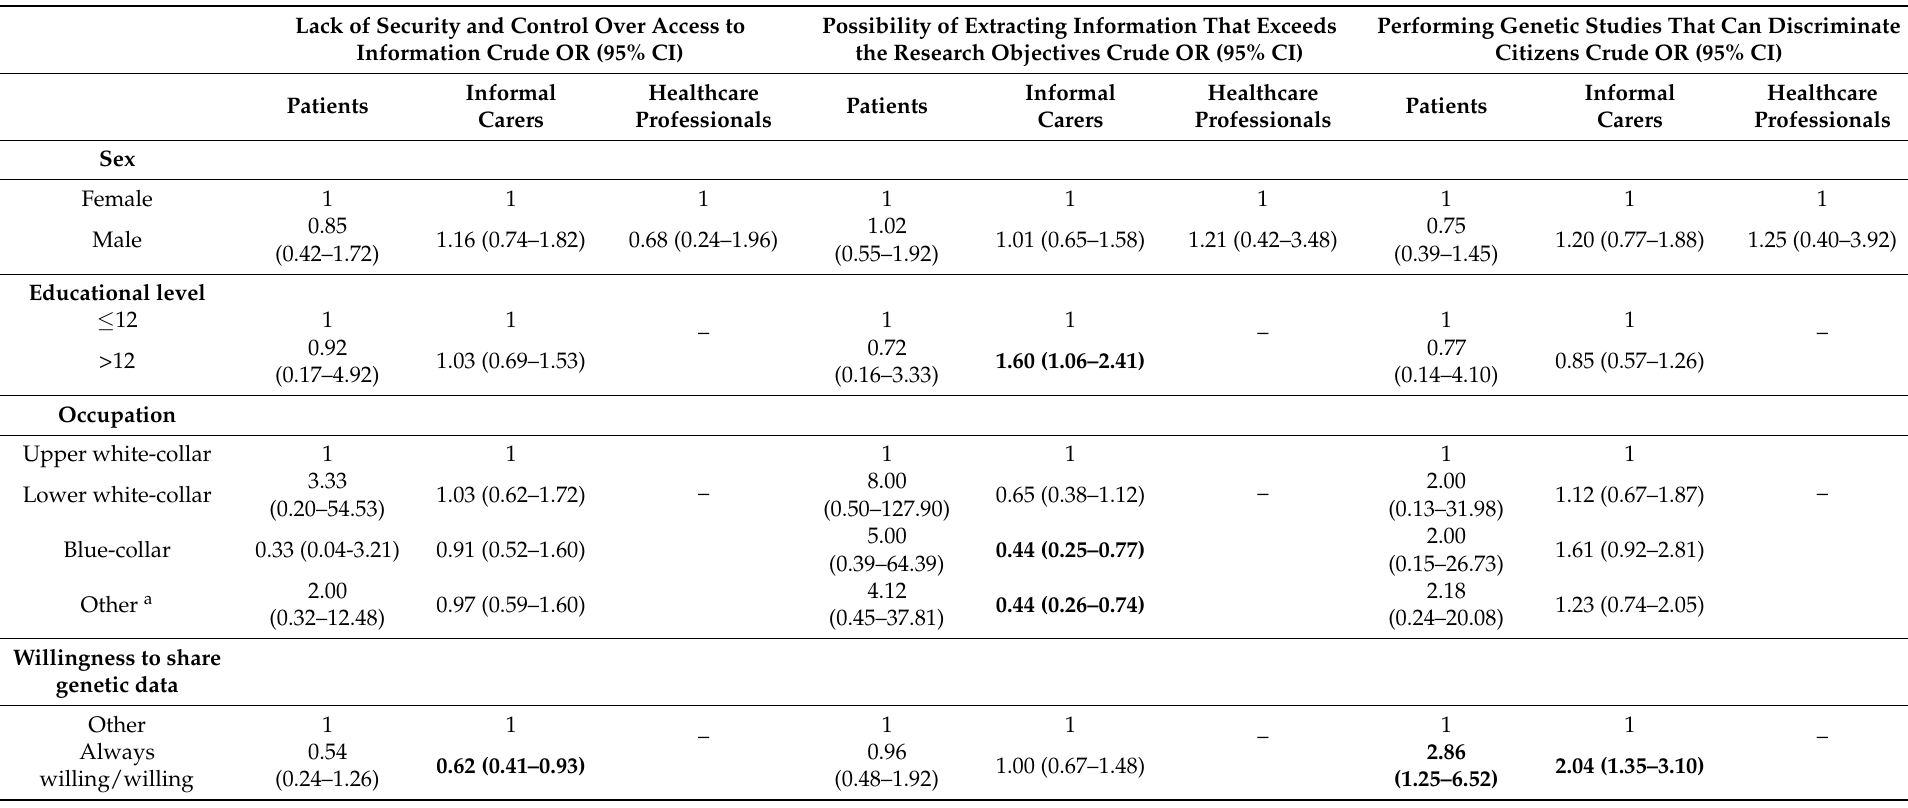
Table 4. Factors associated with selecting the risks of sharing genetic information for research, stratified by type of participant. Lack of Security and Control Over Access